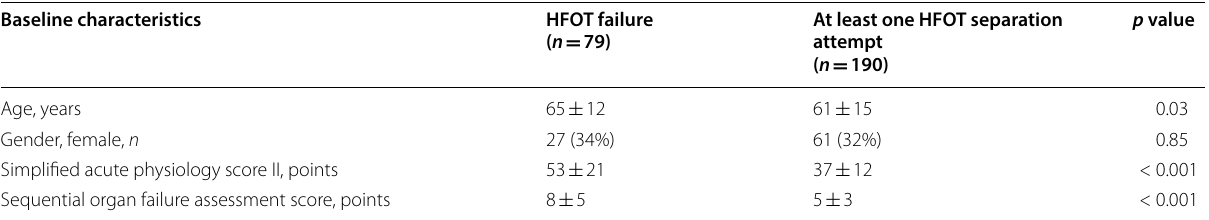
Table 1 Baseline characteristics of patients who failed under HFOT and who had at least one HFOT separation